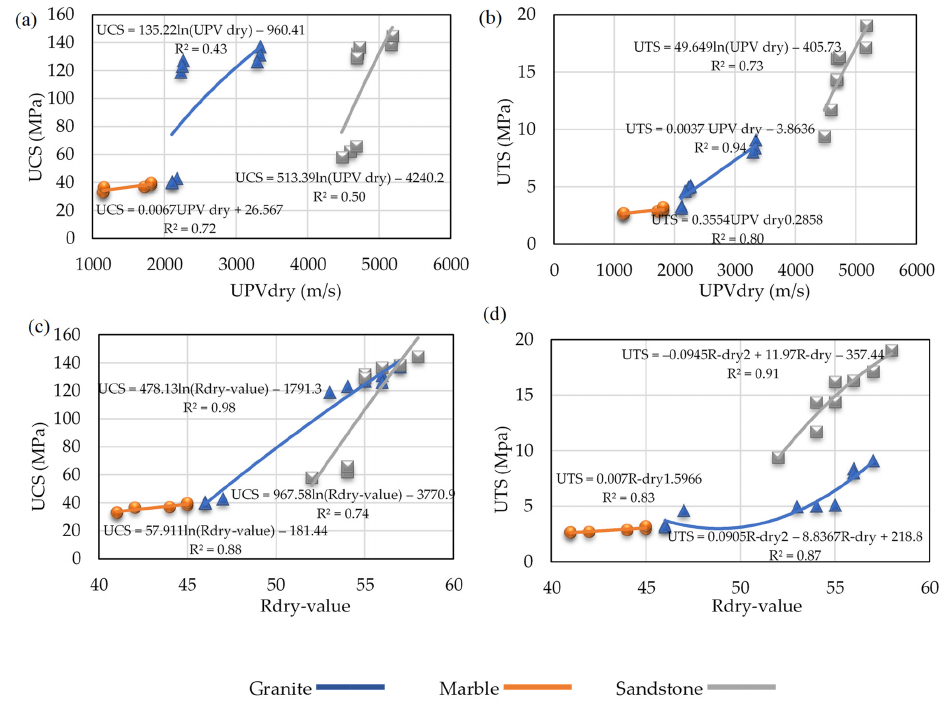
Figure 10. Correlation of NDT against UCS and UTS for granite, marble, and sandstone ( a ) USC vs. UPVdry ( b ) UTS vs. UPVdry ( c ) UCS vs. Rdry-value. ( d ) UTS vs. Rdry-value. Table 8. Statistical relations of dry-state NDTs with strength Using NDT’s equations, the computed values of UCS and UTS are displayed against the observed values in Figure 11 (Table 9). Table 9. Measured and calculated values of the strength properties of the studied rocks.